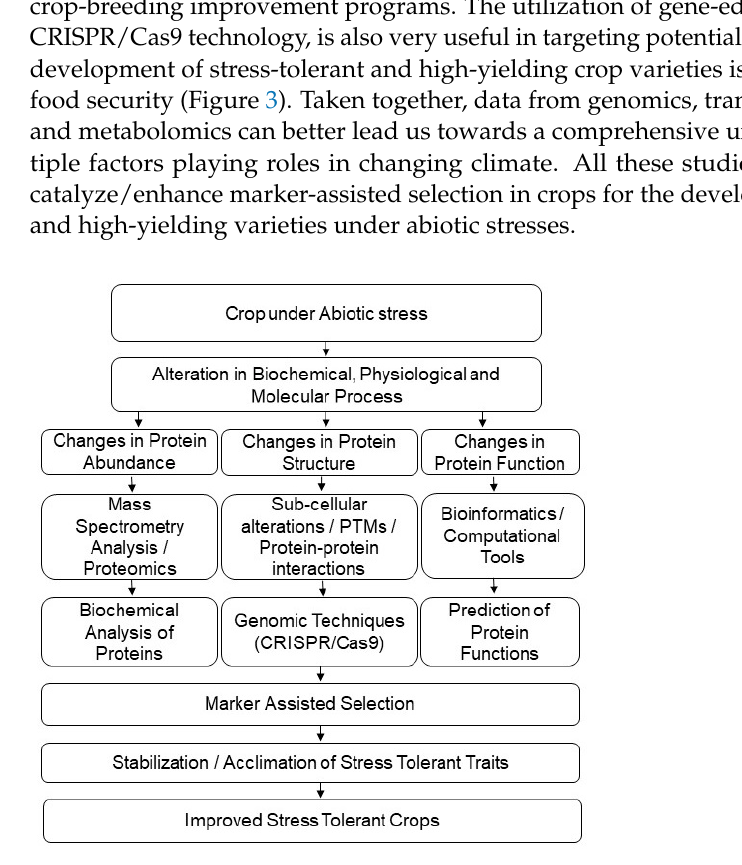
Figure 3. Application of proteomic techniques for crop improvement under abiotic-stress condi- tions.